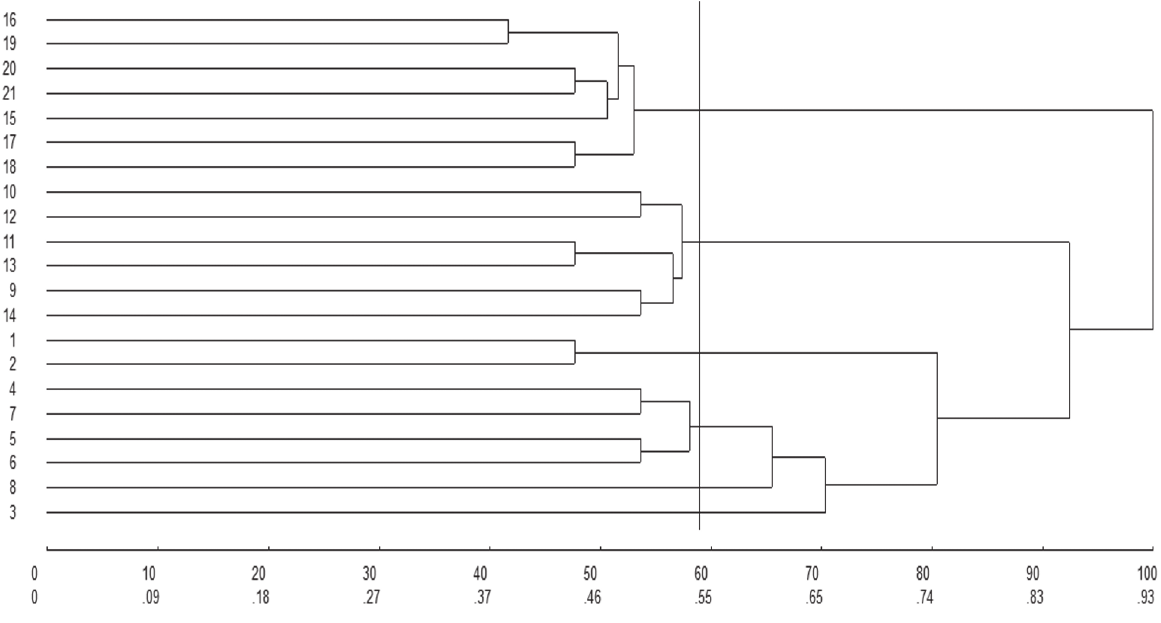
Figure 4 - Dendrogram obtained by cluster analysis using the mean Euclidean distance and the UPGMA method, for measuring the output of the second collection of honey. Set of 20 variables in 21 honey samples of A. mellifera in the counties of Marechal Cândido Rondon and Santa